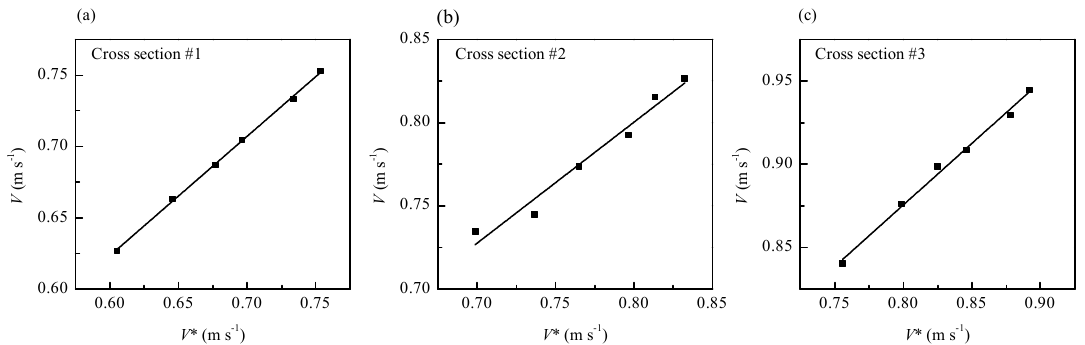
Figure 2. Fitting curves of velocity at fixed points versus the cross-sectional averaged velocity ( V − V * relationships): ( a ) the V – V * relationship at cross section #1; ( b ) the V – V * relationship at cross section #2; ( c ) the V – V * relationship at cross section #3. Table 1. Relative error between the observed and calculated accumulative discharges at each cross section in man-made flood